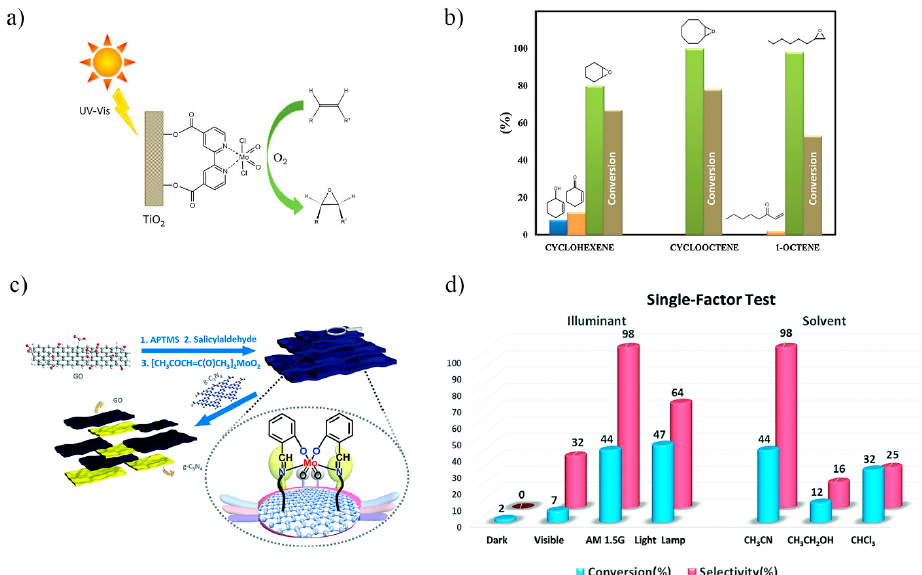
Figure 6. ( a ) Proposed photo-epoxidation catalyzed by dichloro dioxo-(4,4 ′ -dicarboxylato-2,2 ′ - bipyridine) molybdenum (VI) grafted on mesoporous TiO 2 ; ( b ) selectivity and conversion values for the photo-oxidation of different alkenes catalyzed by Mo (VI) Cl 2 O 2 Bipy/TiO 2 (SC-150) after reacting for 35 h. Reproduced with permission from reference [90]. Elsevier (2016). ( c ) Synthetic route to prepare Mo-GO/g-C 3 N 4 composite; ( d ) photocatalytic performance of Mo-GO/g-C 3 N 4 during cyclooctene epoxidation assessed using different illuminants a and solvents b . a Reaction conditions: cyclooctene (10 mmol), CH 3 CN (10 mL, solvent), chlorobenzene (5 mmol), catalyst (10 mg) and O 2 . The mixture was continuously stirred under different illuminants for 6 h. b Reaction conditions: cyclooctene (10 mmol), solvent (10 mL), chlorobenzene (5 mmol), catalyst (10 mg) and O 2 . The mixture was continuously stirred under a Xe lamp (300 W) with an AM 1.5 G filter for 6 h. Reproduced with permission from reference [91]. Royal Society of Chemistry (2018).